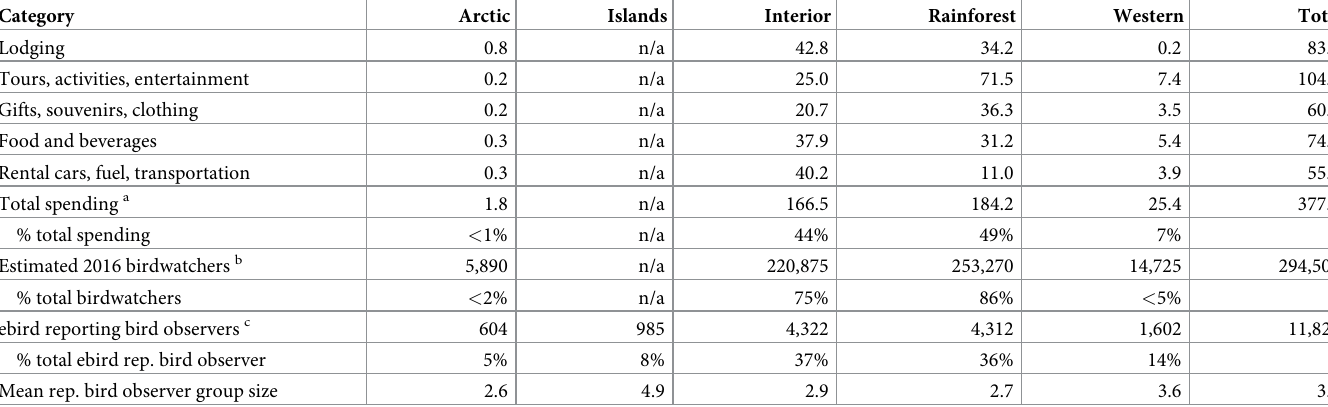
Table 3. Alaska bird tourism expenditures by category in 2016 $ million and bird watch effort by Bird Conservation